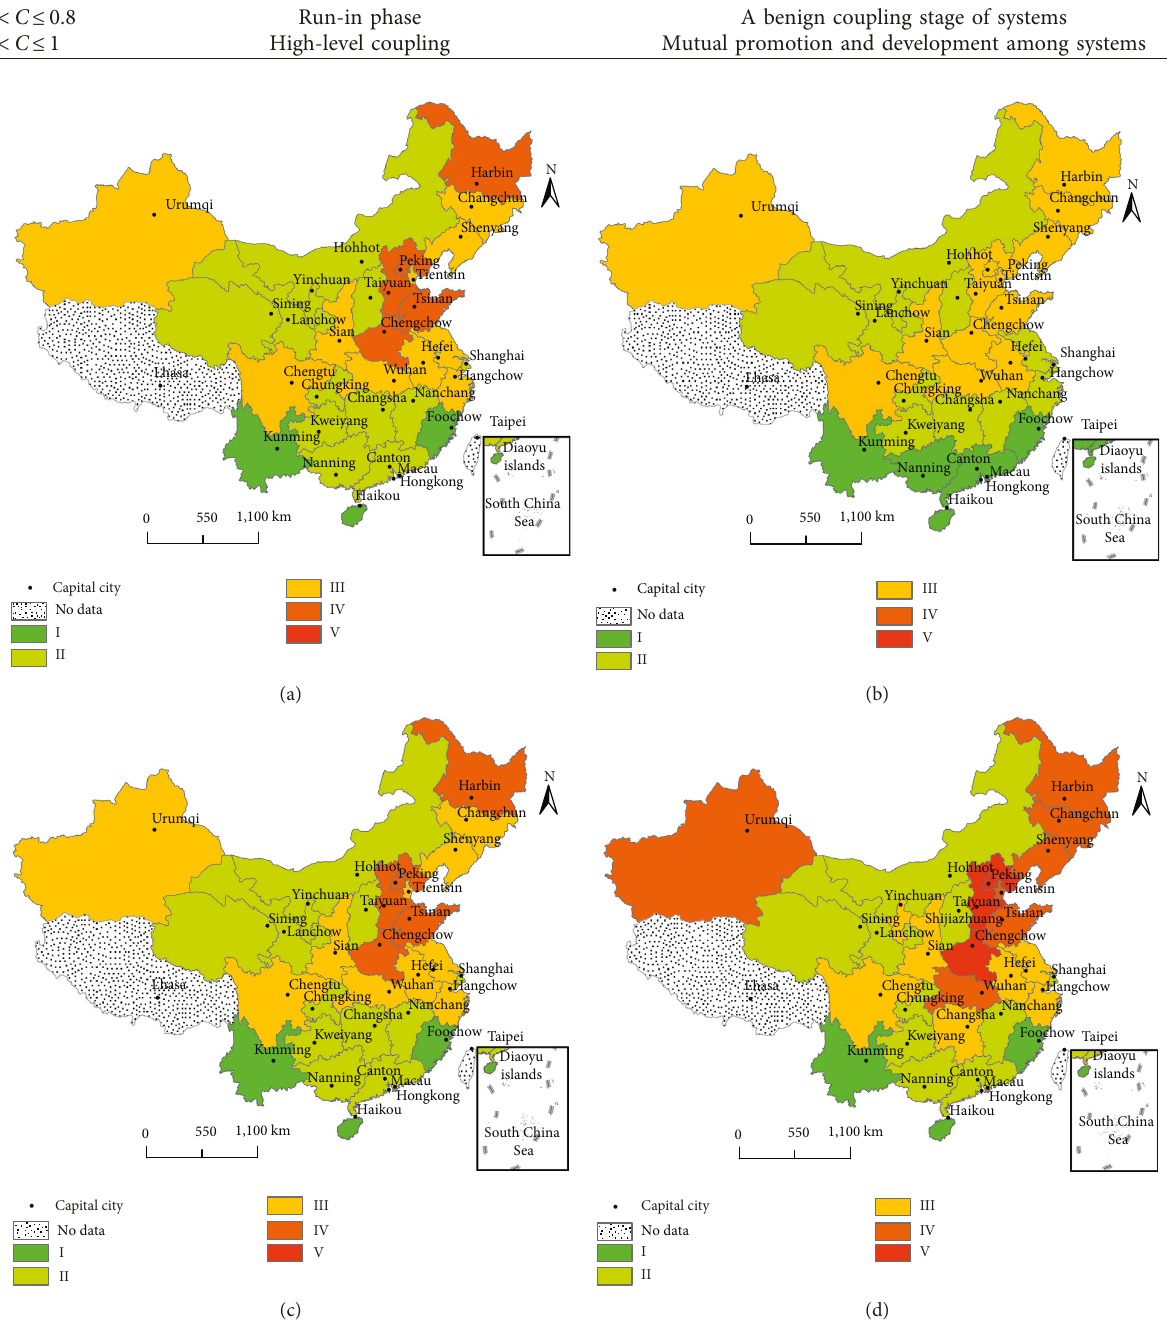
Figure 1: Spatial distribution of the human settlements quality index in provincial capitals: (a) the first quarter; (b) the second quarter; (c) the third quarter; (d) the fourth